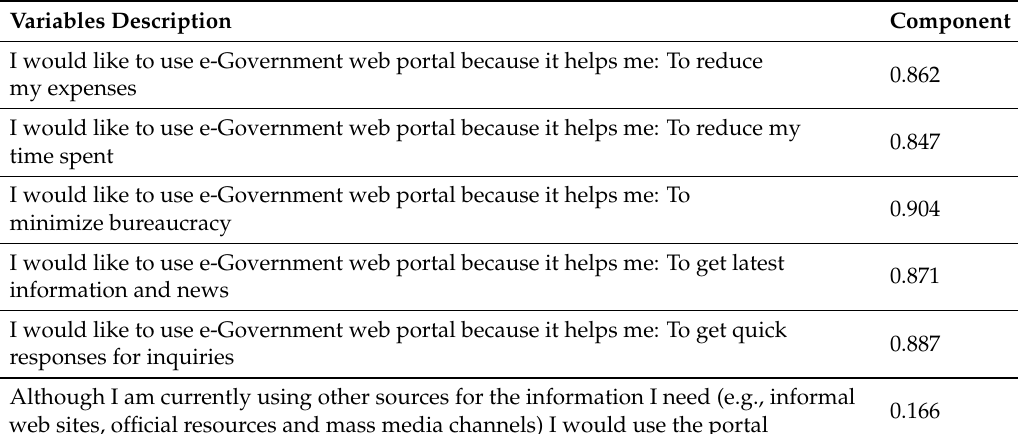
Table A7. Component matrix of BI